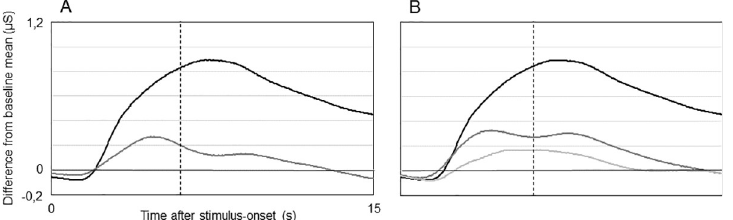
Fig 5. Averaged SCR to auditory stimuli during true biofeedback and sham feedback. A: Total averages (n = 20) of SCR to negative (black) and neutral (grey) auditory stimuli while providing true biofeedback. B: Total averages (n = 20) of SCR to negative auditory stimuli while providing true biofeedback (black) and sham feedback suggesting strong (dark grey) and weak activation (light grey). Signal courses depict differences from baseline mean (set to zero on the y-axis). Vertical dotted lines indicate end of auditory stimulation (after 6s). For purposes of presentation, curve progressions are smoothed using a sliding average of one second (32 data